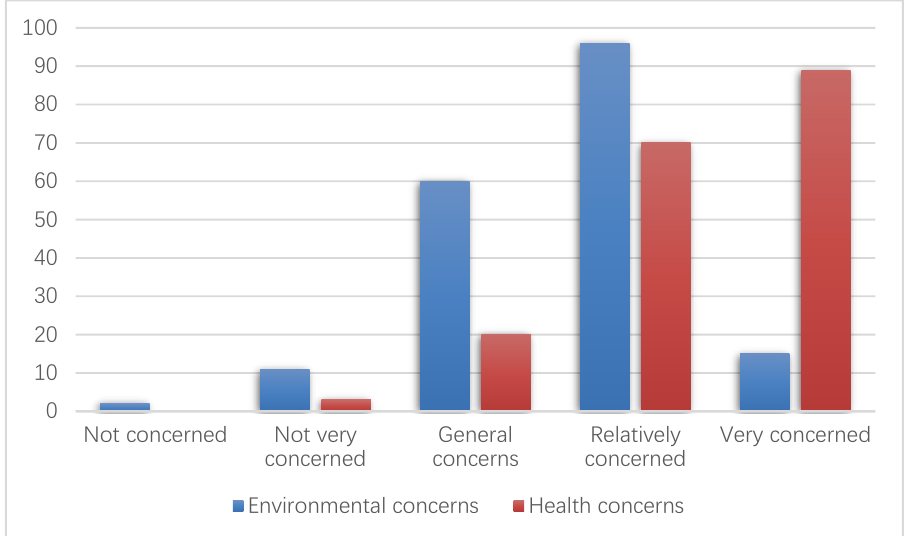
Figure 11. Consumers’ Concern for Health and Environmental